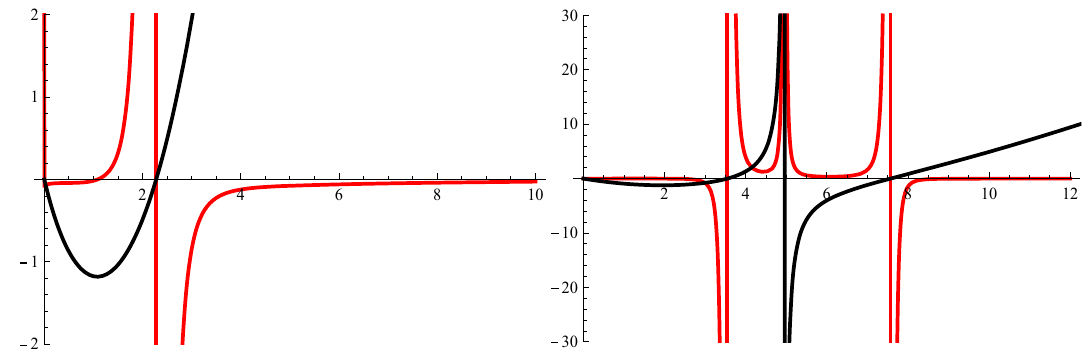
Fig. 6 R ( red ) and C Q ( black ) versus S for (cid:11) = − 3 , b = 1 , Q = 2. Left: R and 2 C Q , α < 1, α = 0 . 75 , a = 2 . Right: 0 . 2 R and 2 C Q , α > 1, α = 1 . 5 , a = 1 .